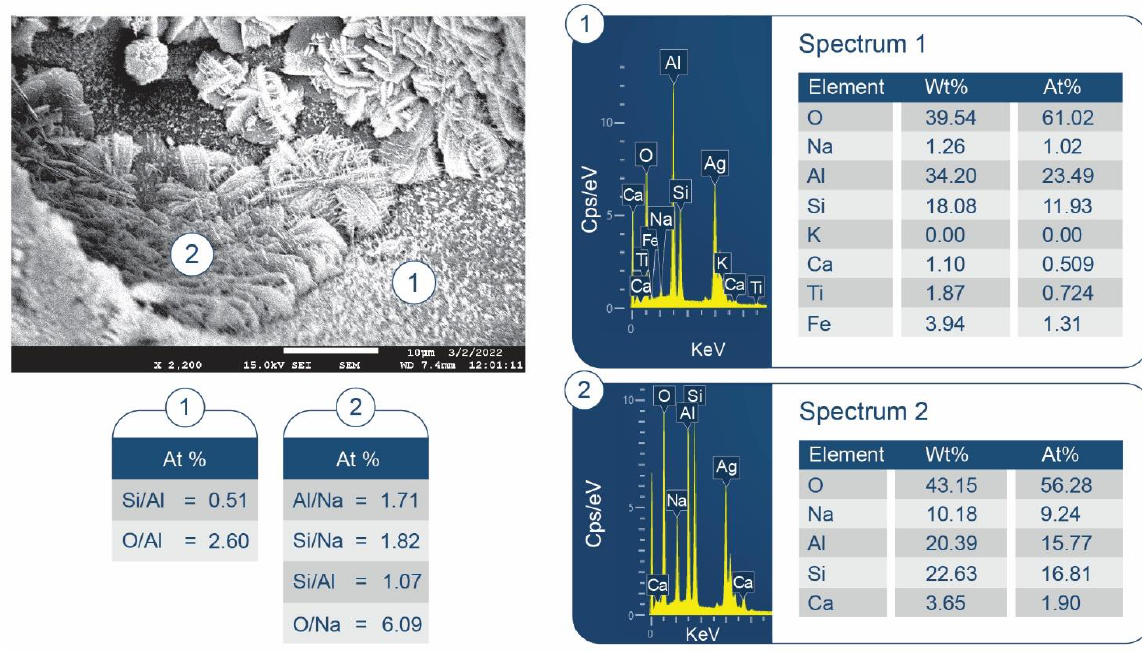
Figure 11. Morphology and elemental composition of freshly fractured neat CaP/FCS cement after curing at 250 °C.